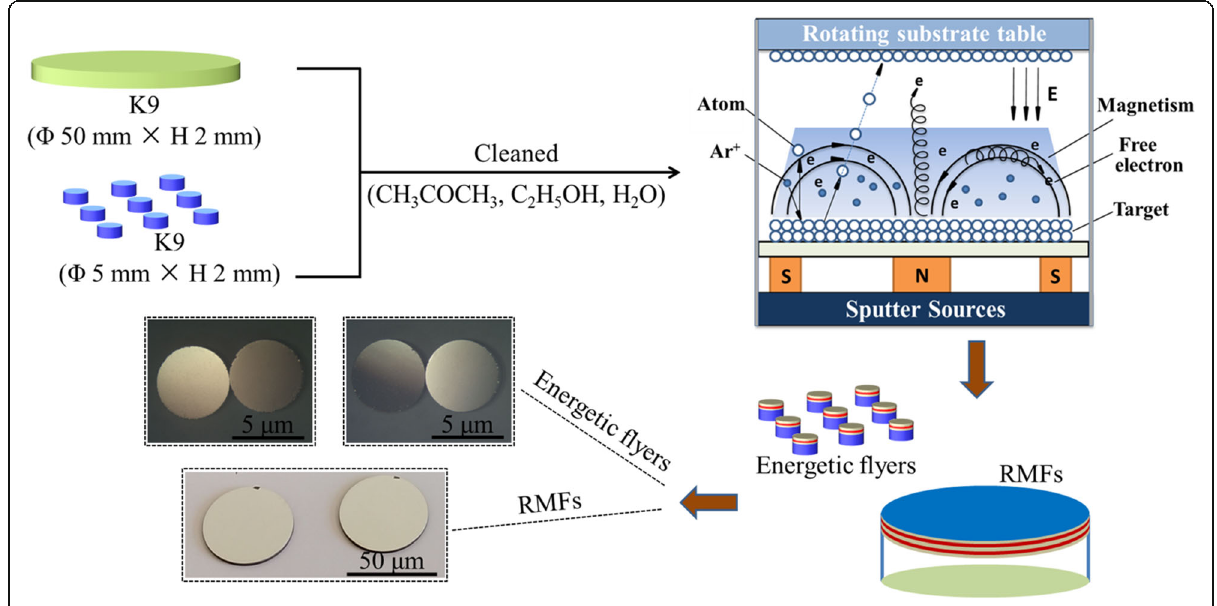
Fig. 1 The depositing formation process of RMFs and EFPs